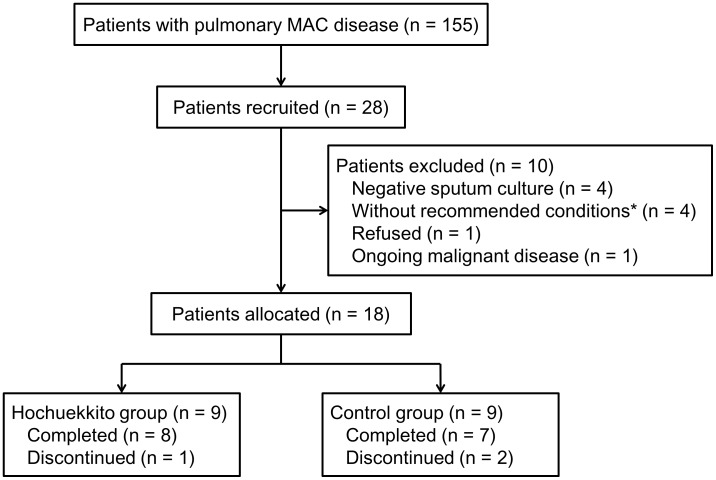
Patient inclusion/exclusion.MAC  =  Mycobacterium avium complex. *Declined physical strength, general fatigue, or appetite loss.